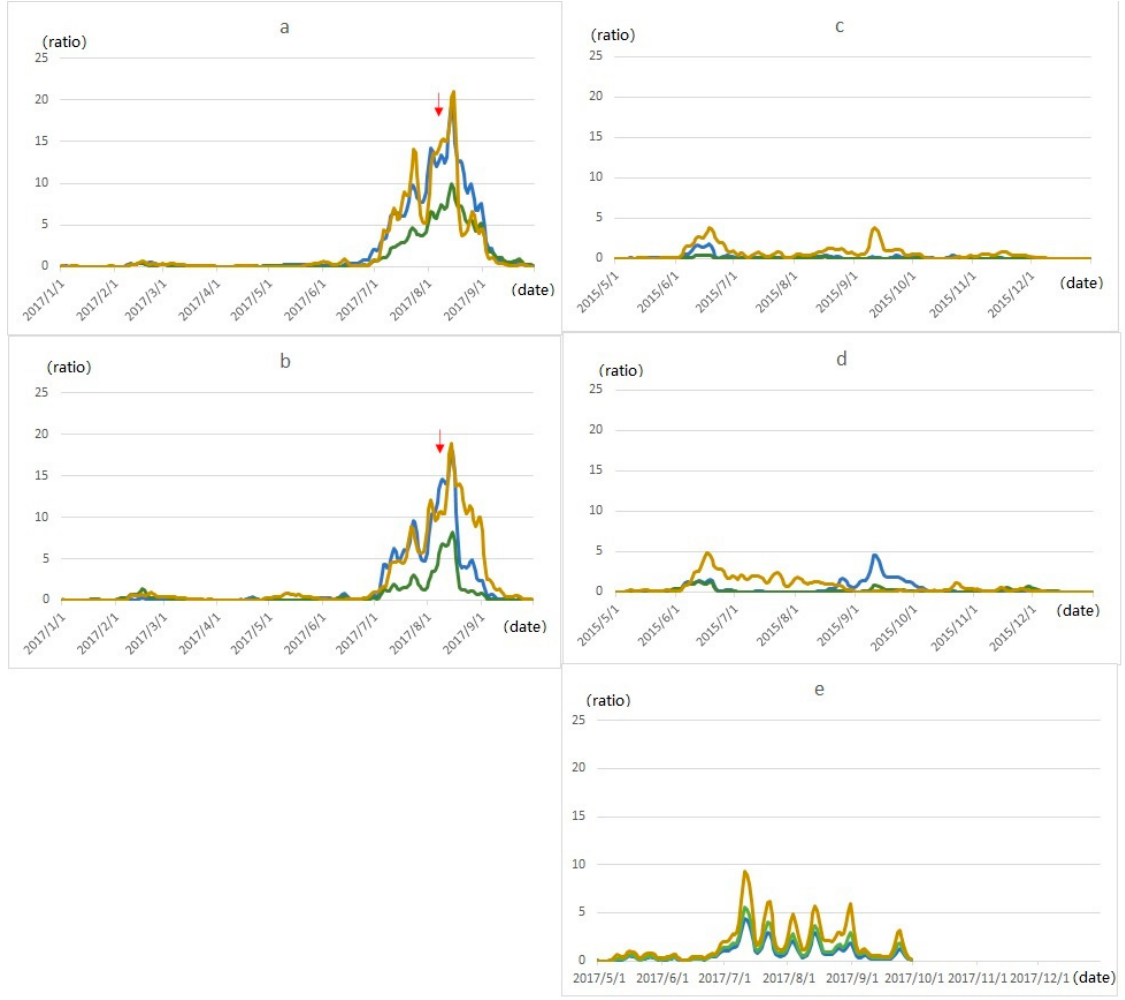
Figure 6. Power spectra time series of temperature of brightness blackbody (TBB; blue lines), outgoing longwave radiation (OLR; green lines), and medium-wave infrared brightness (MIB; orange lines) showing thermal radiation anomalies in ( a ) Region 1 and ( b ) Region 2 and showing periods with no thermal radiation anomalies in ( c ) Region 1, ( d ) Region 2, and ( e ) the epicenter region. Red arrows denote the day of the 2017 M w 6.5 Jiuzhaigou earthquake.